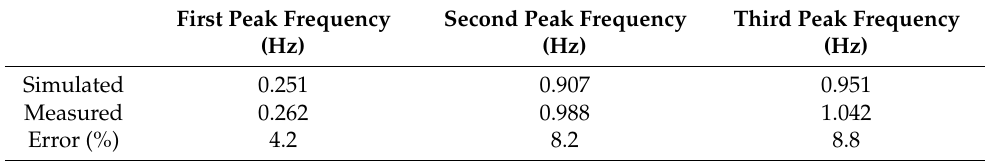
Table 5. Comparison of peak frequency between simulated value and measured value.